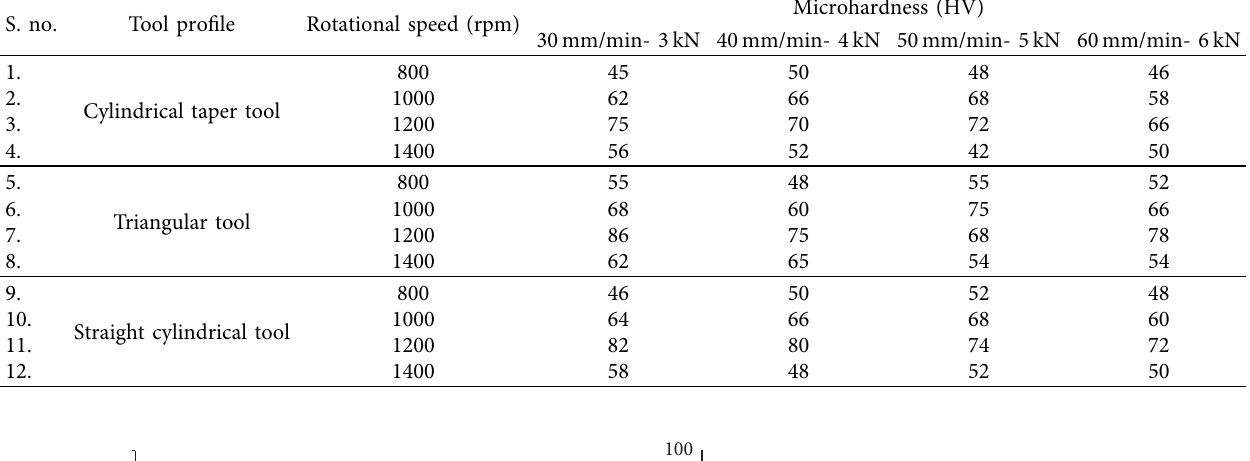
Table 6: Summary of different tool profiles with microhardness.